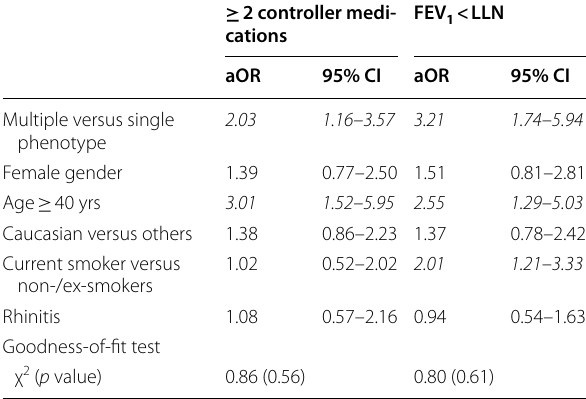
Table 4 Regression models with significant associations between having multiple asthma phenotypes and asthma- related outcomes, adjusted for